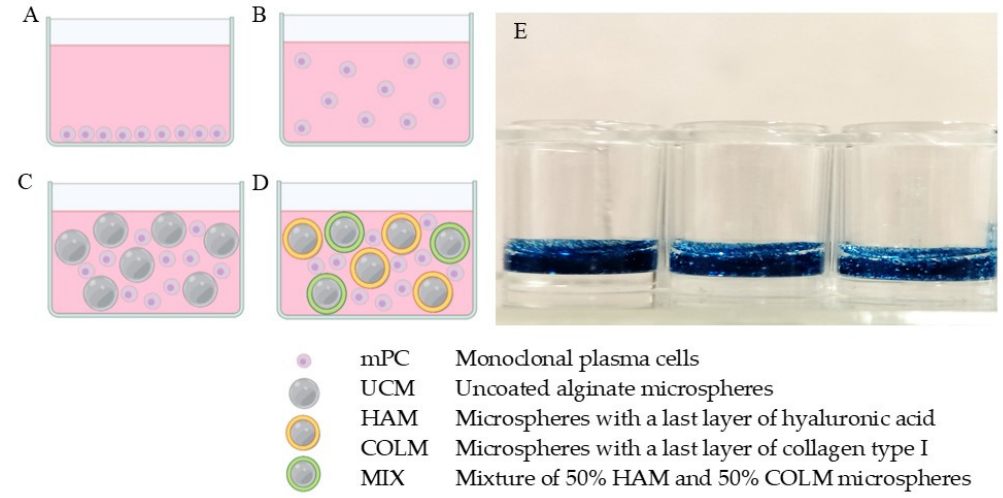
Figure 3. Graphic representation of the different forms of cultivation performed: ( A ) conventional 2D culture; ( B ) suspension culture (SUP condition); ( C ) suspension culture incorporating non-functionalized alginate microspheres (UCM condition); and ( D ) representation of suspension culture in an environment with components of the extracellular matrix incorporating 50% of alginate microspheres with the last layer of hyaluronic acid and 50% of collagen type I (MIX condition). mPC, monoclonal plasma cell; UCM, alginate microspheres; HAM, alginate microspheres with the last layer of hyaluronic acid; COLM, alginate microspheres with the last layer of collagen type I. ( E ) shows a picture of alginate microspheres stained with Alcian blue and suspended in the aqueous medium of the same proportion as the cell culture.